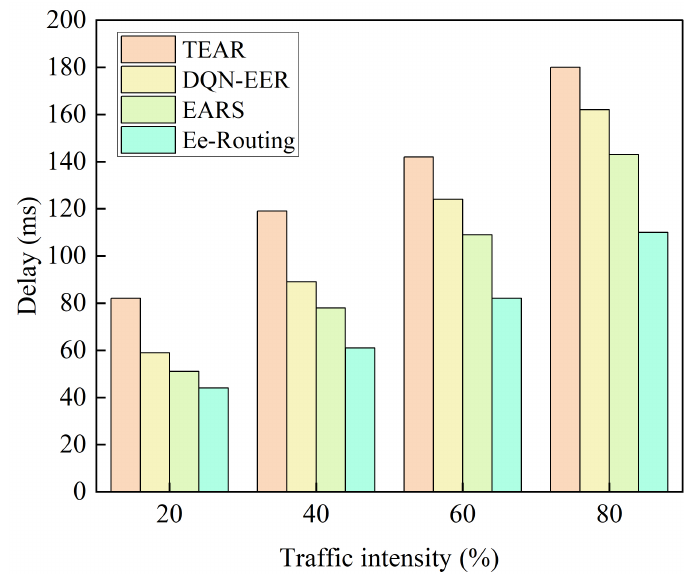
Figure 9. Delay comparison under different traffic intensities.